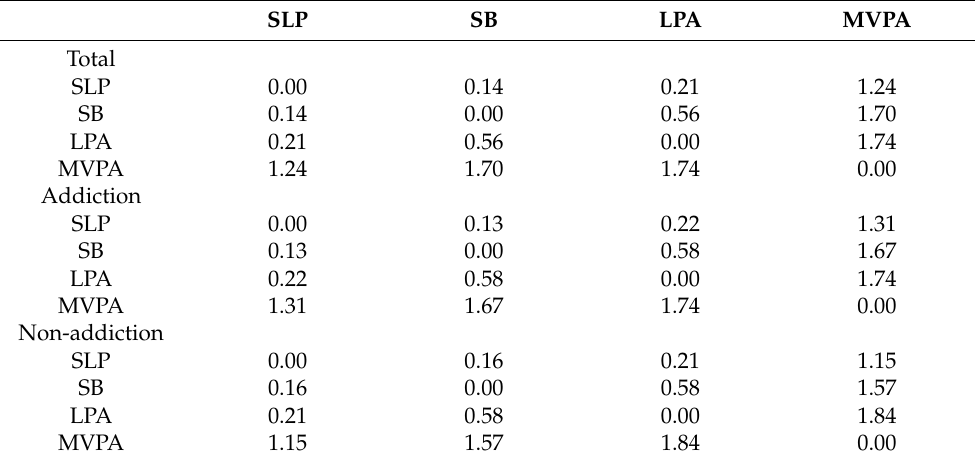
Table 3. Compositional variation matrix of time spent in SB, SLP, LPA and MVPA in minutes/day.